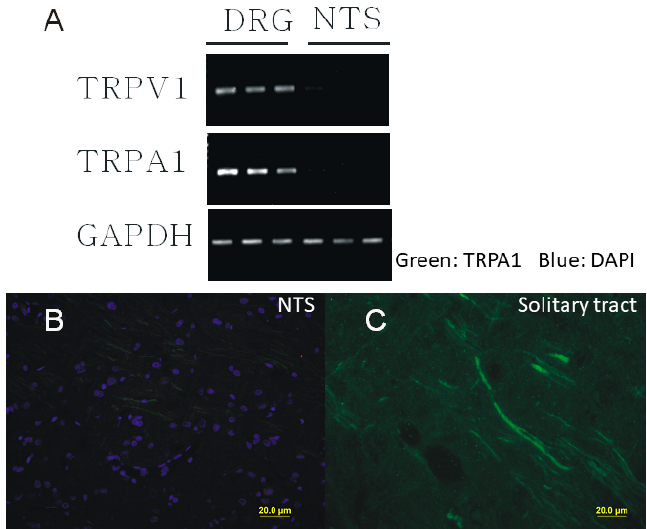
Figure 1. The lack of expression of TRPA1 in the nucleus of the solitary tract (NTS). ( A ) Expression of TRPA1 mRNA in sensory neurons but not in the NTS. ( B , C ) Immunostaining of TRPA1 (green), DAPI (blue) in the NTS. The TRPA1 staining was detected abundantly on the solitary tract, but not within the NTS. DRG: dorsal root